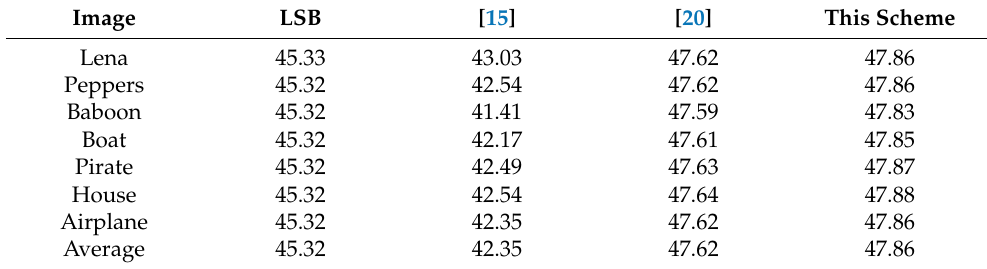
Table 7. Comparison of image